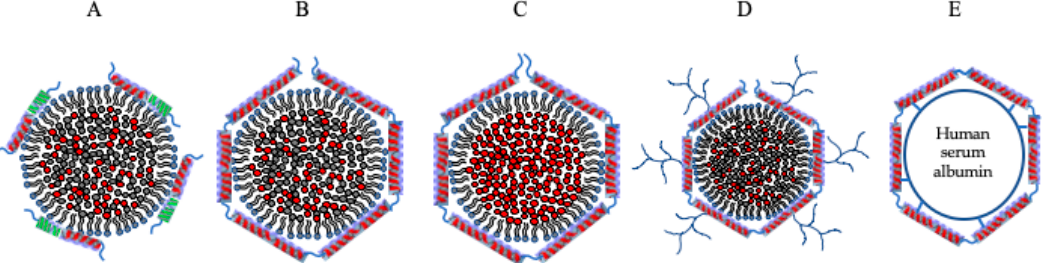
Figure 2. Apolipoprotein-based nanostructures targeting LDLr family of proteins. Nanoparticles bearing ligands, such as apoB-100 or apoE3 or their derivatives, target the LDLr family of